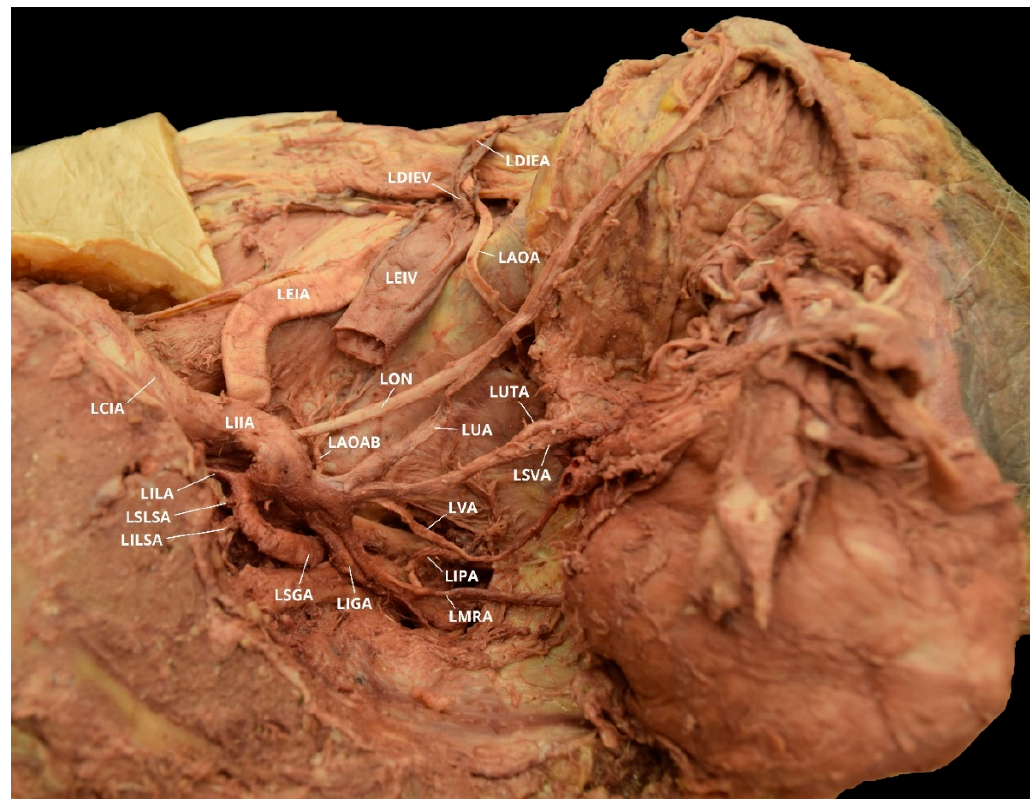
Figure 8. Facilitated display highlighting the left internal iliac artery branches with the left aberrant obturator artery for Case 5. LAOA = Left Aberrant Obturator Artery; LAOAB = Left Accessory Obturator Artery Branch; LCIA = Left Common Iliac Artery; LDIEA = Left Deep Inferior Epigastric Artery; LDIEV = Left Deep Inferior Epigastric Vein; LEIA = Left External Iliac Artery; LEIV = Left External Iliac Vein; LIGA = Left Inferior Gluteal Artery; LIIA = Left Internal Iliac Artery; LILA = Left Iliolumbar Artery; LILSA = Left Inferior Lateral Sacral Artery; LIPA = Left Internal Pudendal Artery; LMRA = Left Middle Rectal Artery; LSVA = Left Superior Vesical Artery; LON = Left Obturator Nerve; LSGA = Left Superior Gluteal Artery; LSLSA = Left Superior Lateral Sacral Artery; LUA = Left Umbilical Artery; LUTA = Left Uterine Artery; LVA = Left Vaginal Artery.